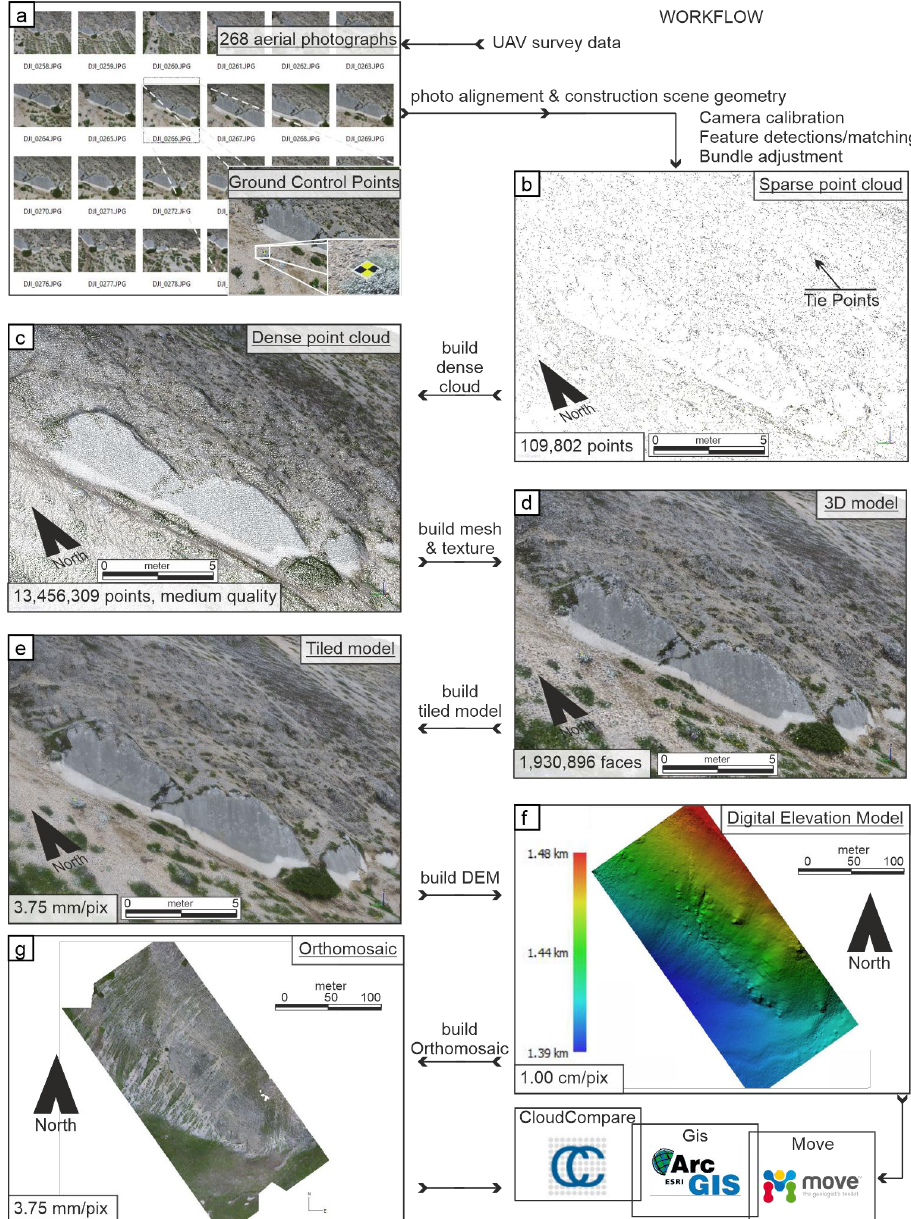
Figure 5. Workflow of the used digital photogrammetry procedure in the sample area 1 (a to g are in-sequence steps): ( a ) overlapping digital aerial photographs and ground control points are imported into the software package; features within the images are automatically detected, matched, and used to calculate locations and orientations of camera shooting points; ( b ) points that have been used for the image alignment form an initial sparse-point cloud (109.802 points); the inclusion of ground control points make the sparse-point cloud automatically georeferenced; ( c ) point densification (multi-view stereo algorithm): points that were manually classified as representing the ground surface are exported as a dense-point cloud (over 13 millions points); ( d ) 3D model construction obtained building meshes between dense-point cloud, with 1,930,896 faces; ( e ) a tiled model is obtained by interpolations of all image acquired during drone survey with faces of 3D model, the final resolution is 3.75 mm / pixel; ( f ) Construction of DSM containing all height values through rasterizing the dense-point cloud or from meshes. The obtained Digital Surface Model has a resolution of 1.00 cm / pixel; while ( g ) the georeferenced orthomosaic with a high resolution of 3.75 mm / pixel was reconstructed interpolating all the photos shooted from the drone. Additional datasets were computed for fracture mapping in a Cloud Compare, ArcGIS, and Move Petex suite